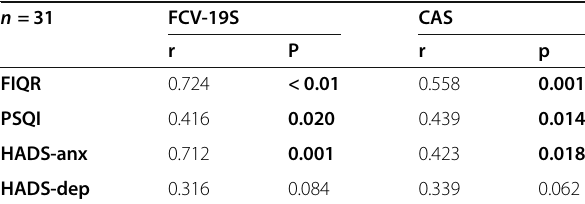
Table 3 Realiation between Fibromiyalgia Impact Questionnare, Pitsburg Sleep Quality Index, Hospital Anxiety and Depression Scale, and Fear of COV İ D-19 Scale, Coronavirus Anxiety Scele in Fibromiyalgia Group